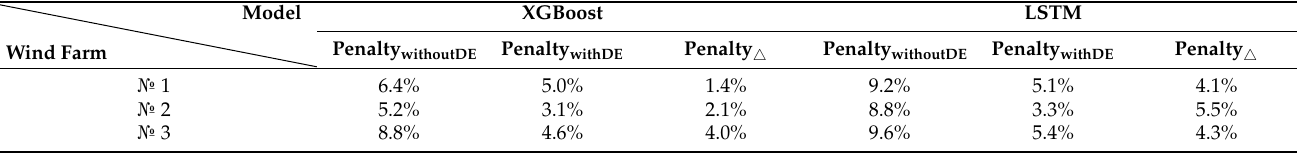
Table 6. Comparison of the penalized power resulting from wind power forecasting errors of two wind energy forecasting models with and without the proposed data enrichment method for three wind